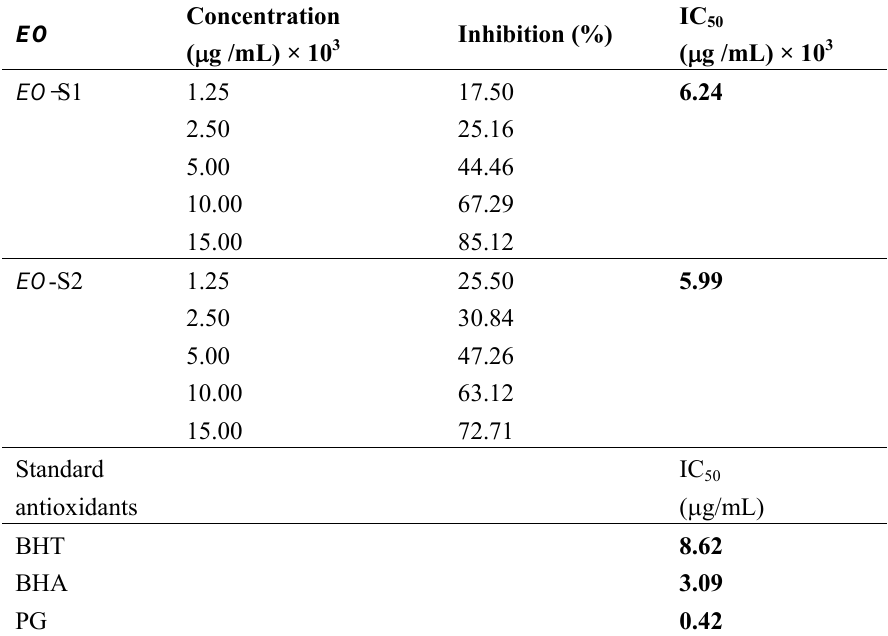
Table 2. DPPH-radical scavenging capacity (RSC) of Myrtus communis essential oils: EO- S1 and EO-S2 and BHA, BHT and PG as positive controls.